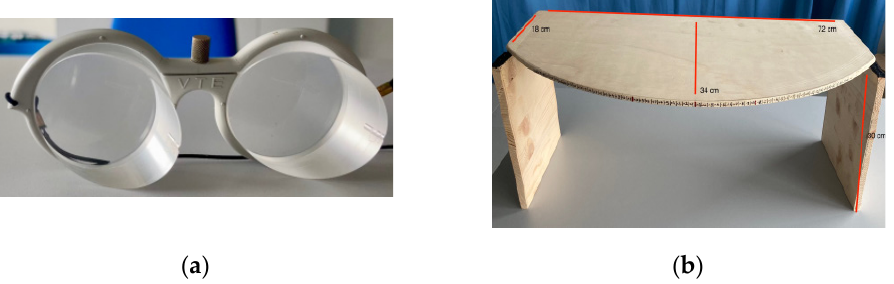
Figure 3. Prism adaptation apparatus. ( a ) Glasses used whit 25° lenses; ( b ) boxes used to perform prismatic adaptation.